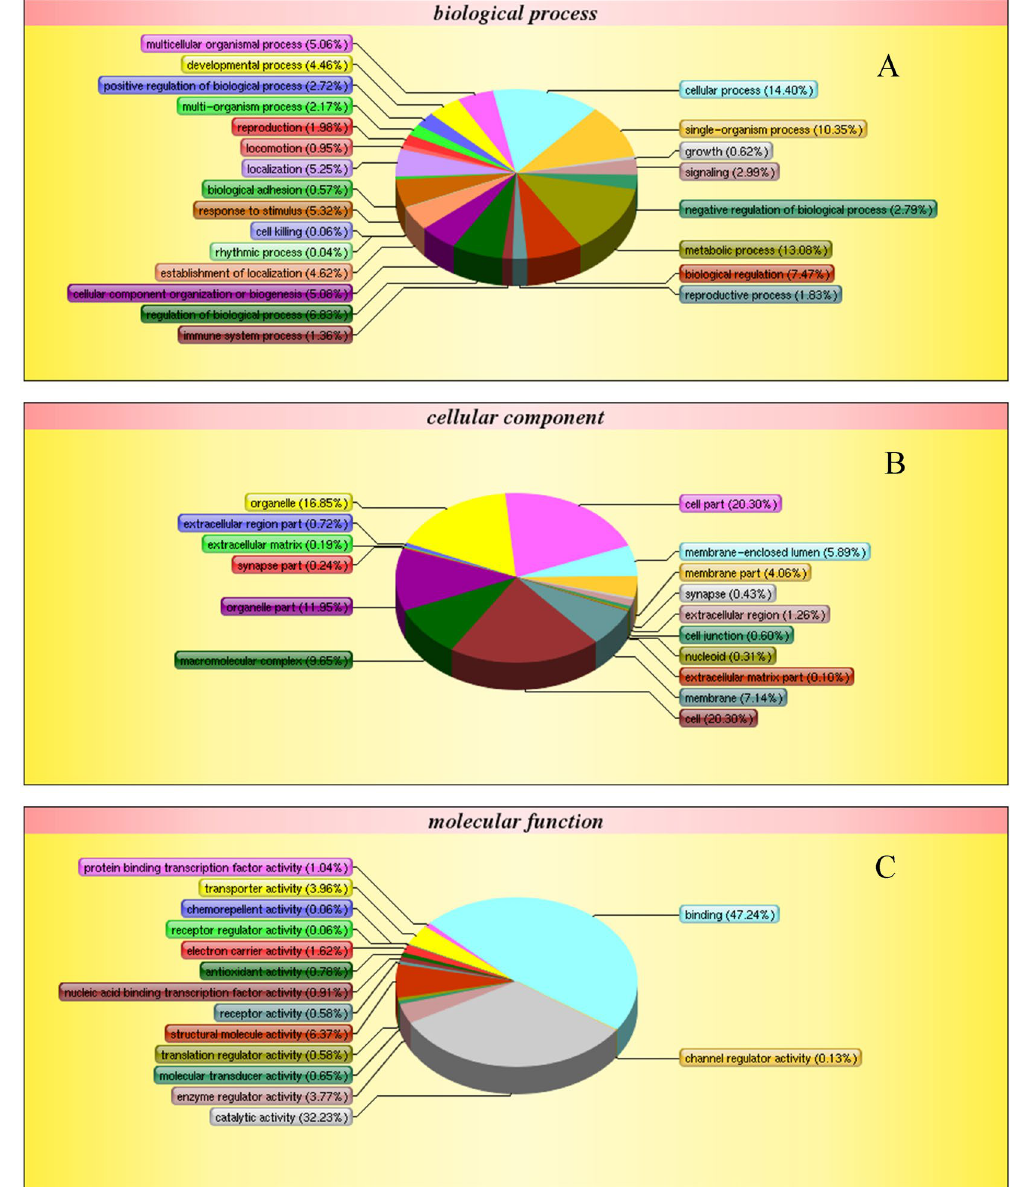
Figure 2. Gene ontology (GO) analysis of all proteins during the embryonic development identified by iTRAQ analysis. The left y-axis indicates the percentage of a specific category of genes existed in the main category, whereas the right y-axis indicates the number of a specific category of genes existed in main category. Shown above is the classification of these proteins in different categories based on biological process ( A ), cellular component ( B ) and molecular function ( C